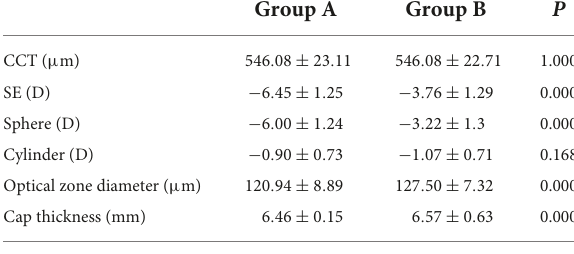
TABLE 2 Posterior corneal elevation (PCE) in groups A and B.